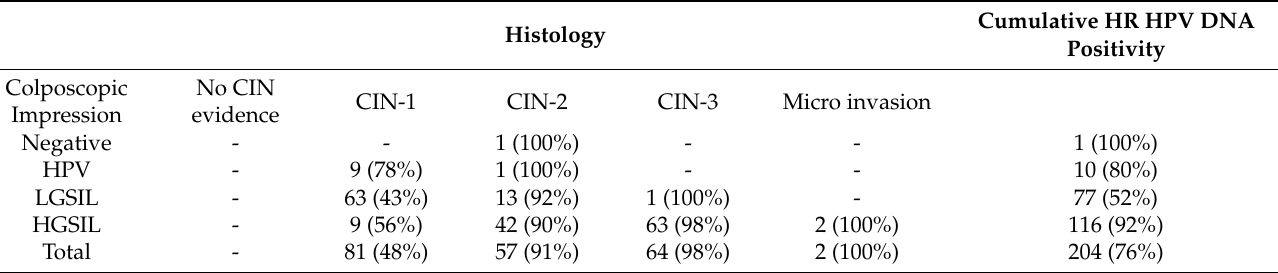
Table 2. Histological results and consistency with colposcopic findings at study